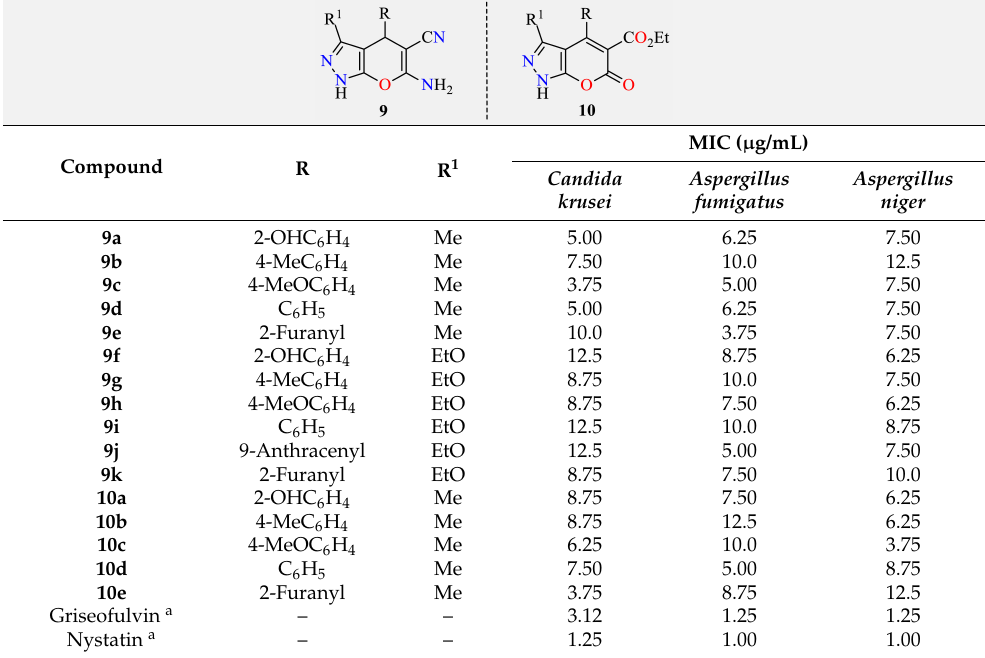
Table 41. Antifungal evaluation of pyrazole derivatives 9 and 10